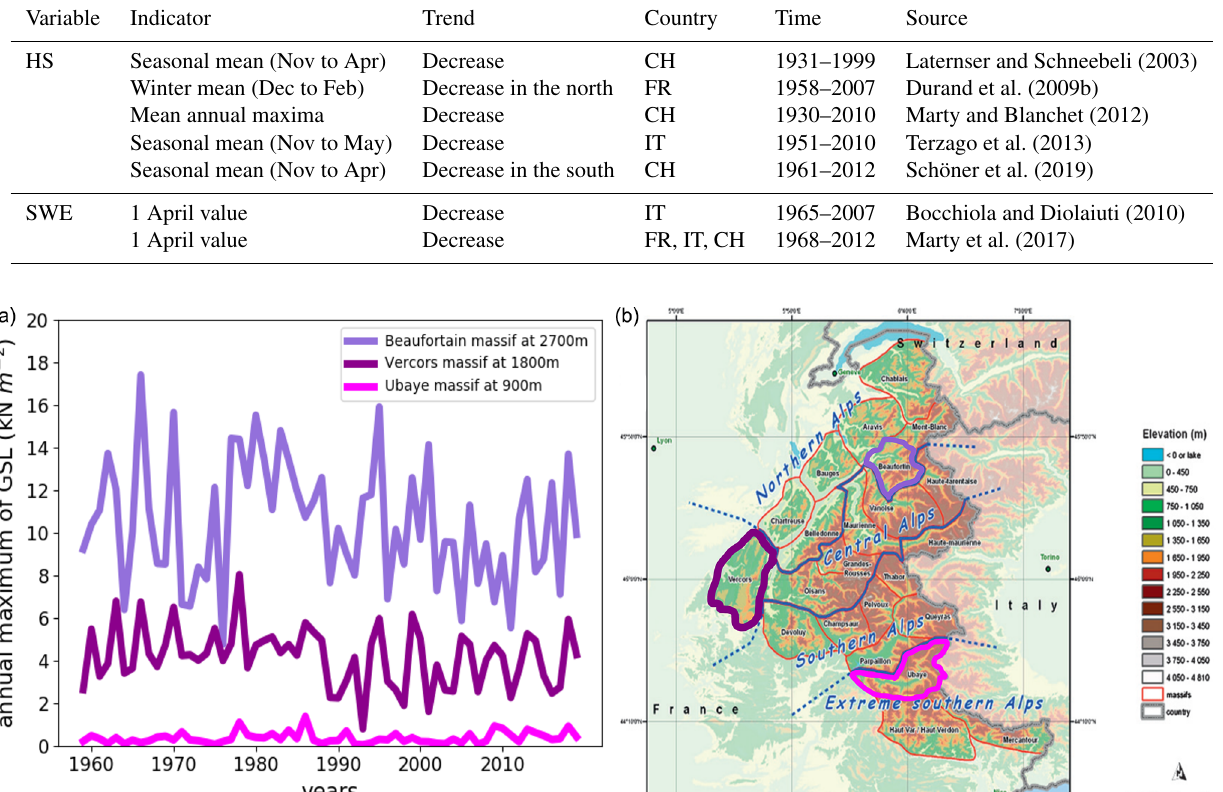
Table 1. Past trends in snowpack variables, snow depth (HS) and snow water equivalent (SWE), according to existing studies in the Western Alps, i.e. in Italy (IT), France (FR) and Switzerland (CH). In the Trend column, “north” and “south” refer to the considered country.